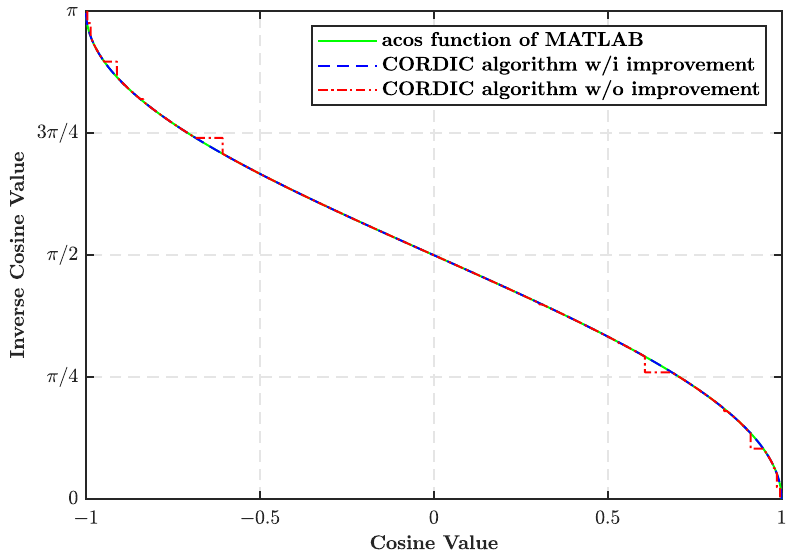
Figure 8. The inverse cosine curve with and without improvement.